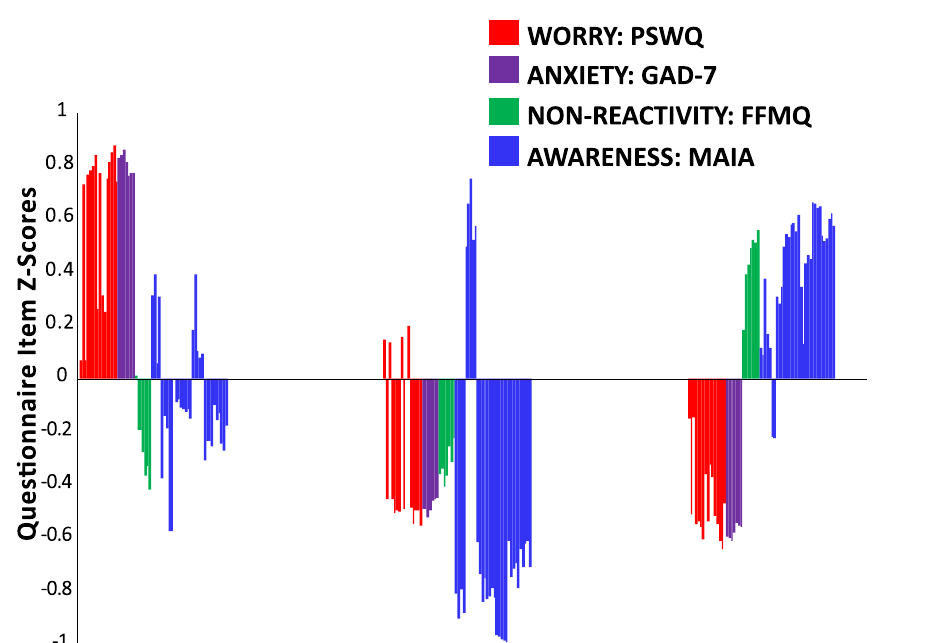
Figure 4. Psychological phenotype composition in the general population. Questionnaire item z-scores for Study 2 participants are shown for Cluster 1 (n = 5629), Cluster 2 (n = 2982), Cluster (n = 5399): PSWQ: Penn State Worry Questionnaire (red); GAD-7: Generalized Anxiety Disorder 7-item Scale (purple): FFMQ: Non- Reactivity Subscale of the Five Facet Mindfulness Questionnaire (green); MAIA: Multidimensional Assessment of Interoceptive Awareness